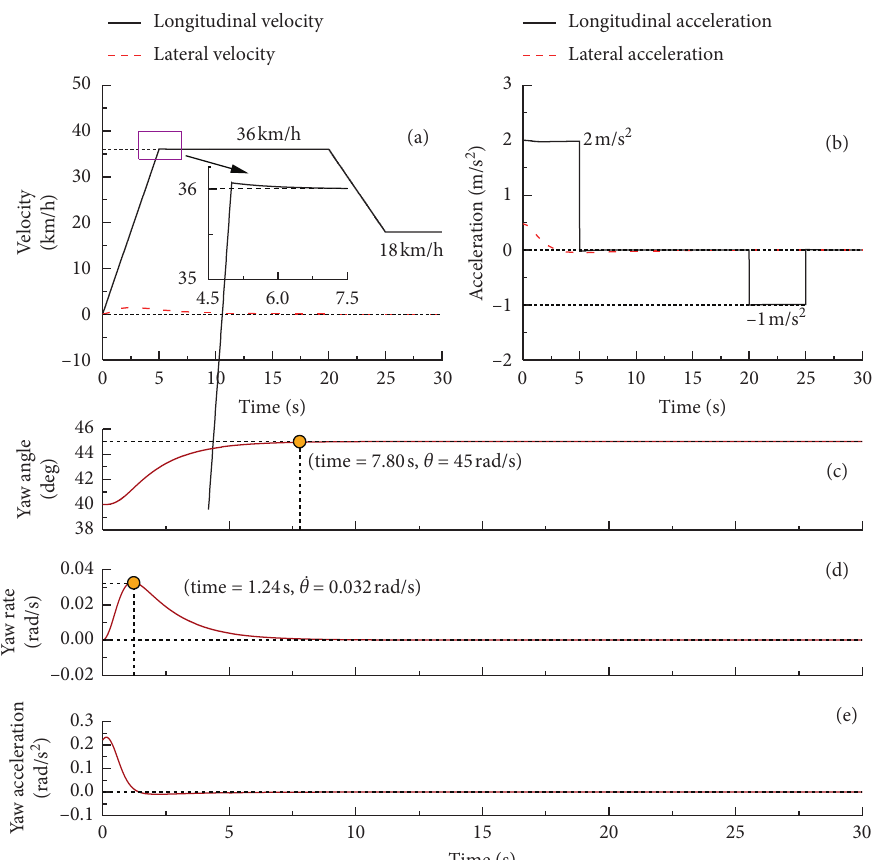
Figure 7: Time histories for several state variables of the vehicle in the straight path-following motion: (a) velocity, (b) acceleration, (c) yaw angle, (d) yaw rate, and (e) yaw acceleration.